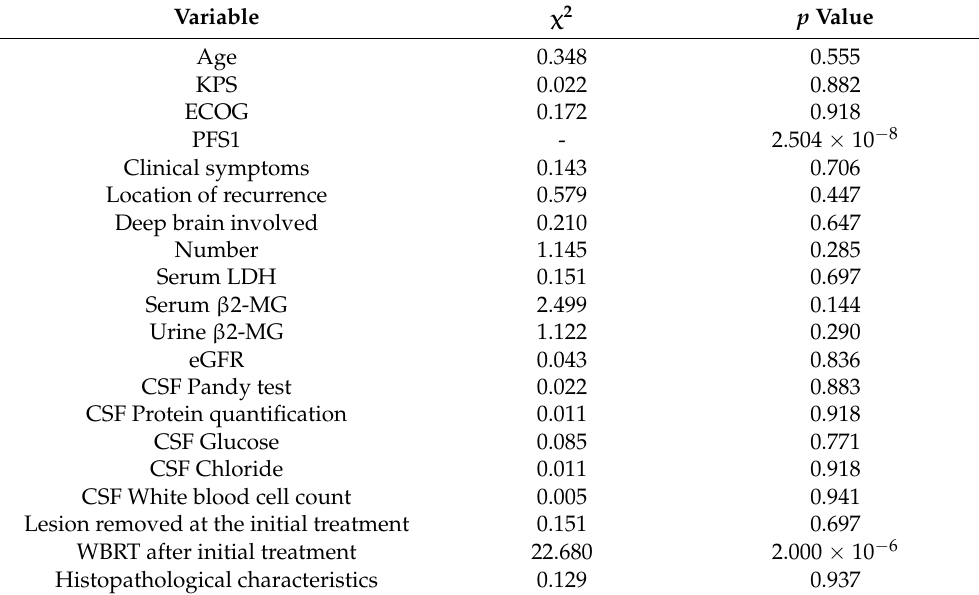
Table 3. Univariate analysis of the response to HD-MTX rechallenge treatment with clinical characteristics.